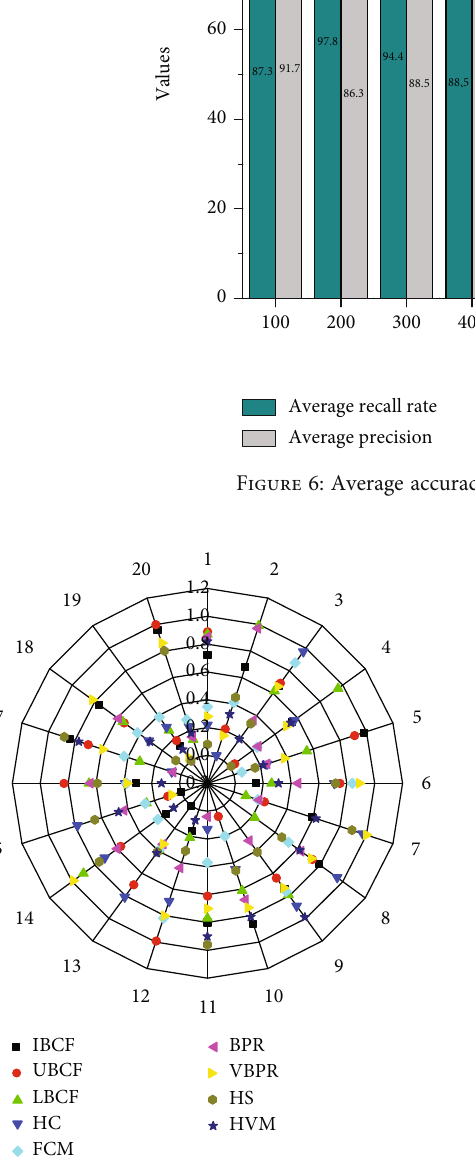
Figure 7: Comparison of recall values for recommended